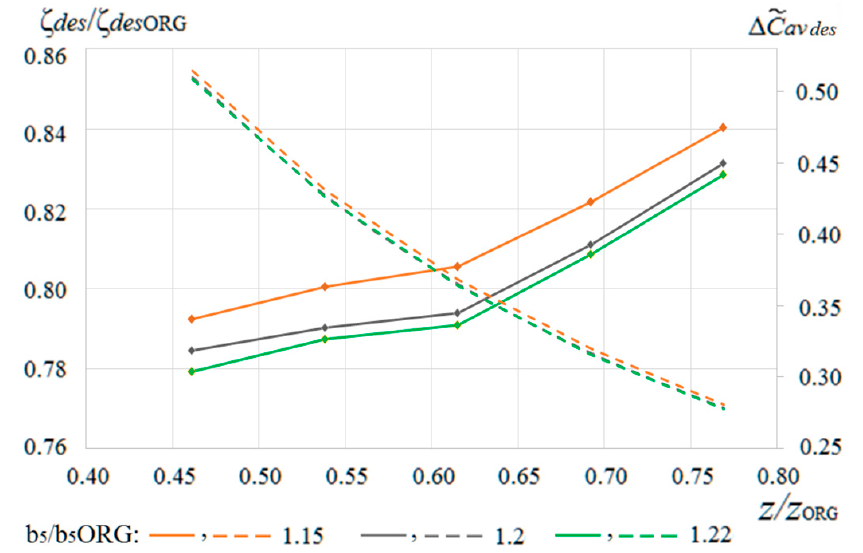
Figure 20. Normalized loss coefficient of return channels with different z / z ORG , b 5 / b 5 ORG and their vane load. Dotted— ∆ (cid:101) c av des